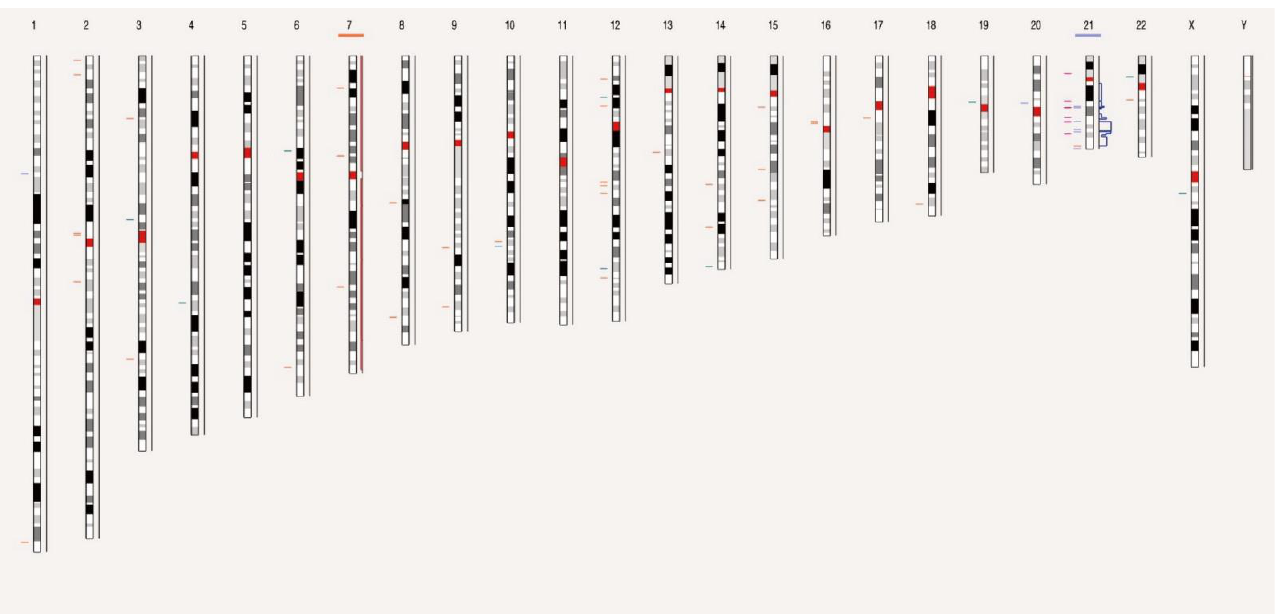
Figure 1. View of the distribution of SVs and CNVs on chromosomes of sample 48. Chromosome 7 and 21 missed or gained one chromatid, respectively. Each chromosome is divided into color-coded bands. The short horizontal lines in different colors on the left side of the chromosome represent the SV composition, including deletion, insertion, duplication, translocation, and inversion, respectively, while those on the right side of the chromosome represent gain or loss of CNV in different bands.